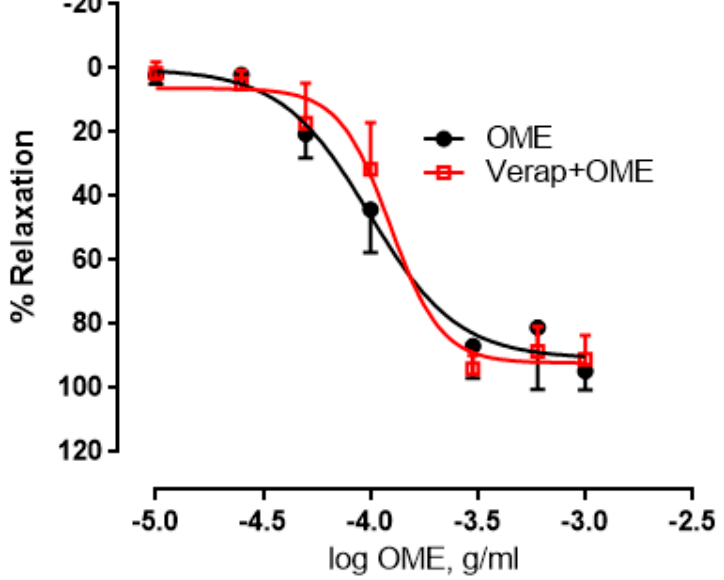
Figure 7. Role of calcium channels in OME-induced relaxation of aortic rings. Endothelium-intact aortic rings were pre-incubated with OME in the absence (OME; black) or presence of verapamil (verap) (1 µM; verap + OME; red). Data are presented as mean ± SEM ( n = 5; p > 0.05).